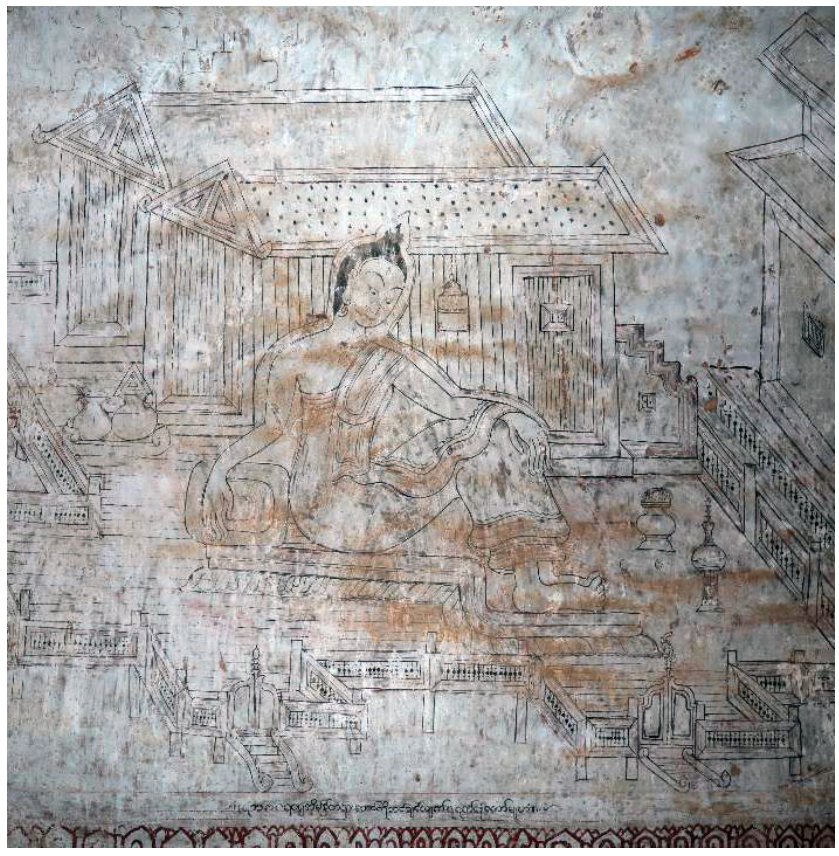
Figure 5. The Buddha seated inside the jeweled house created by the gods, the Fourth Week, Sulamani temple, Bagan.